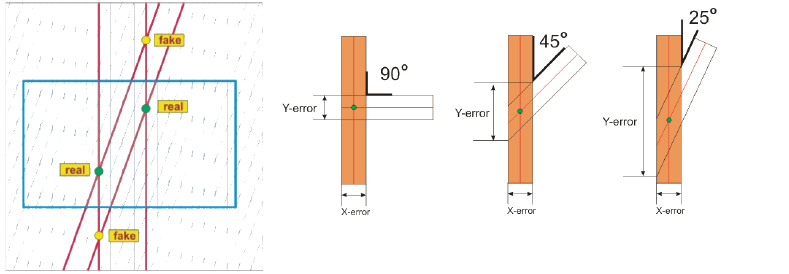
Figure 3. Illustration of “fake”